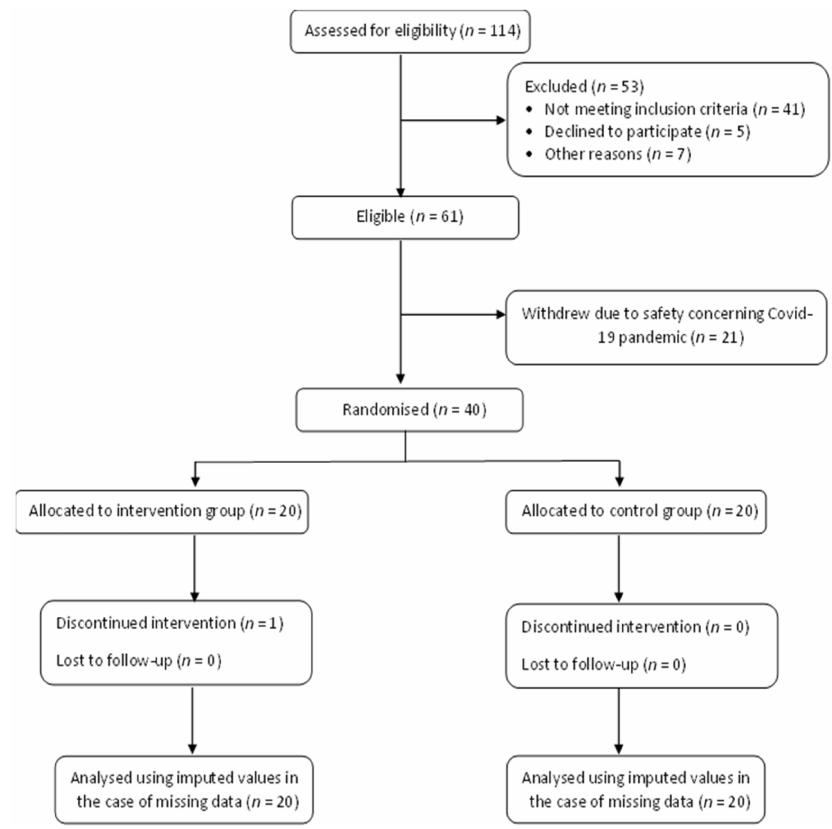
Figure 4. CONSORT